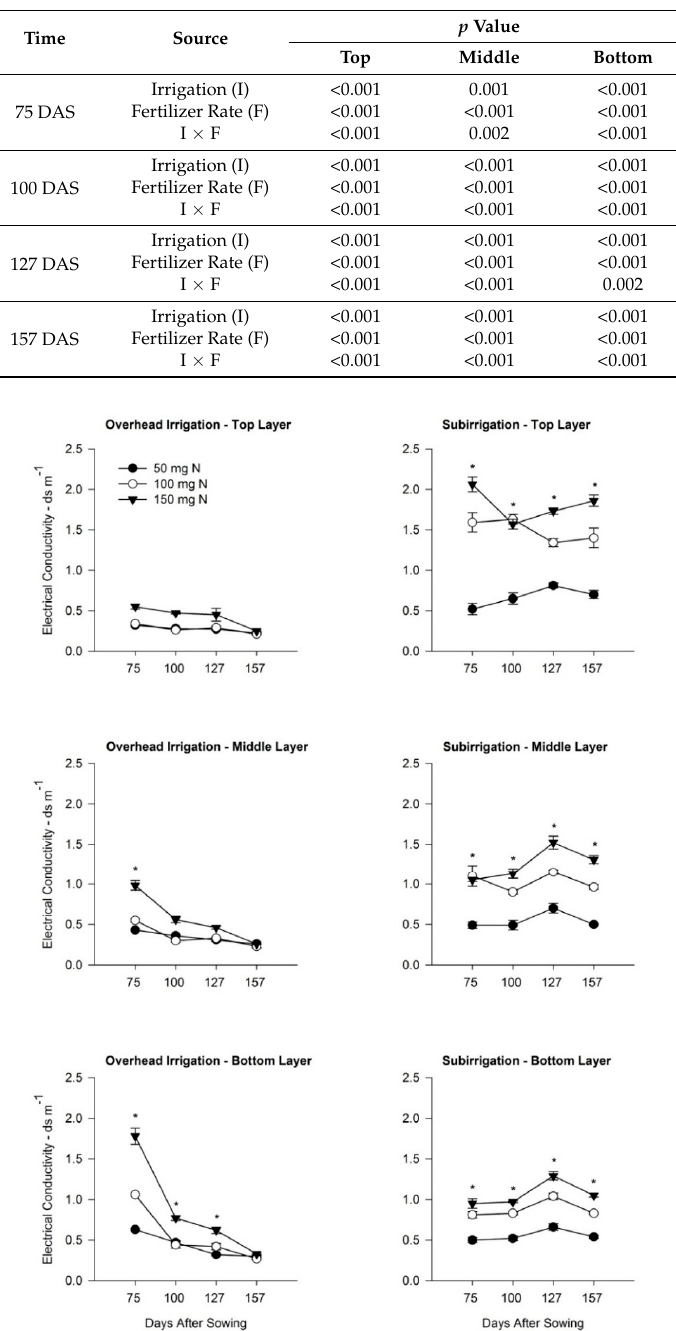
Table 2. p -values for main effect of fertilizer rate and irrigation and their interaction on media EC across the growing season.